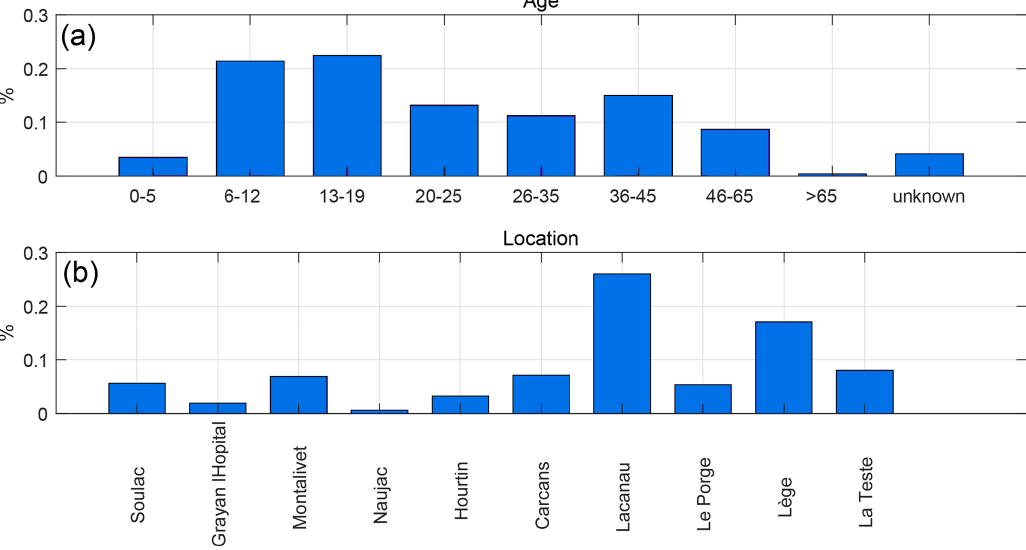
Figure 2. Distribution of (a) age and (b) location of SZIs between 8 January 2011 and 18 November 2017. Beaches are ordered from north (left) to south